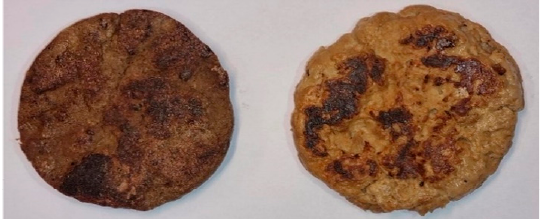
Figure 5. Vegetarian ( left ) and vegan ( right ) burger patties after frying.